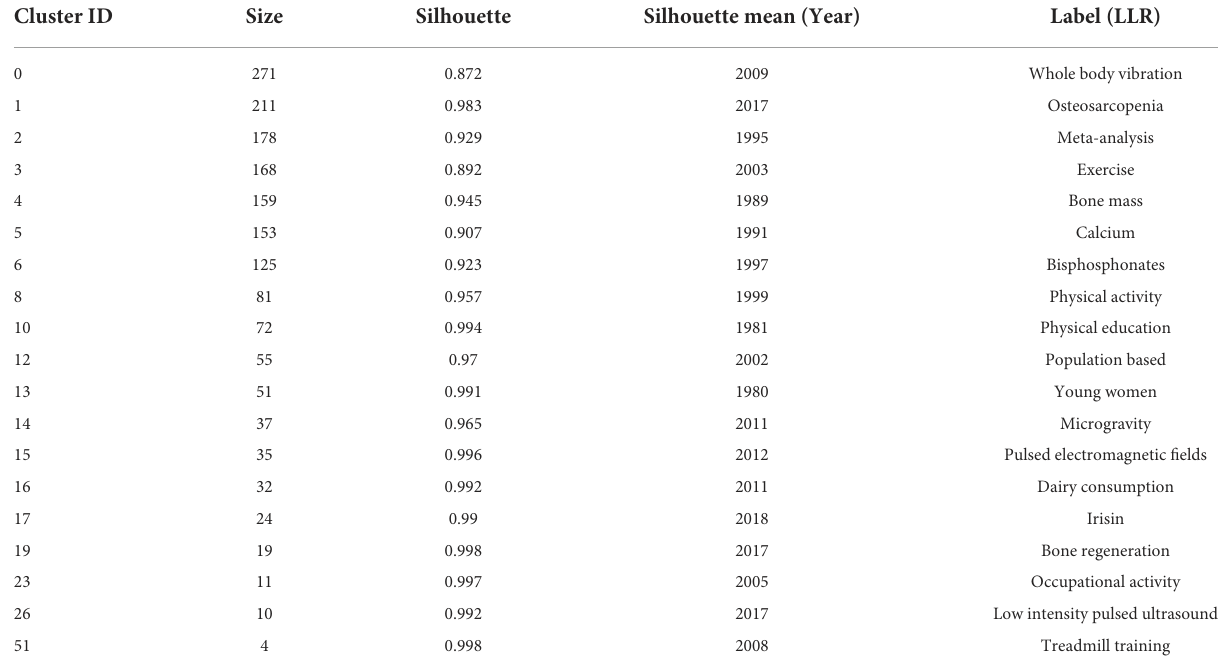
TABLE 4 Co-citation clustering of osteoporosis rehabilitation studies that were published from 1965 to